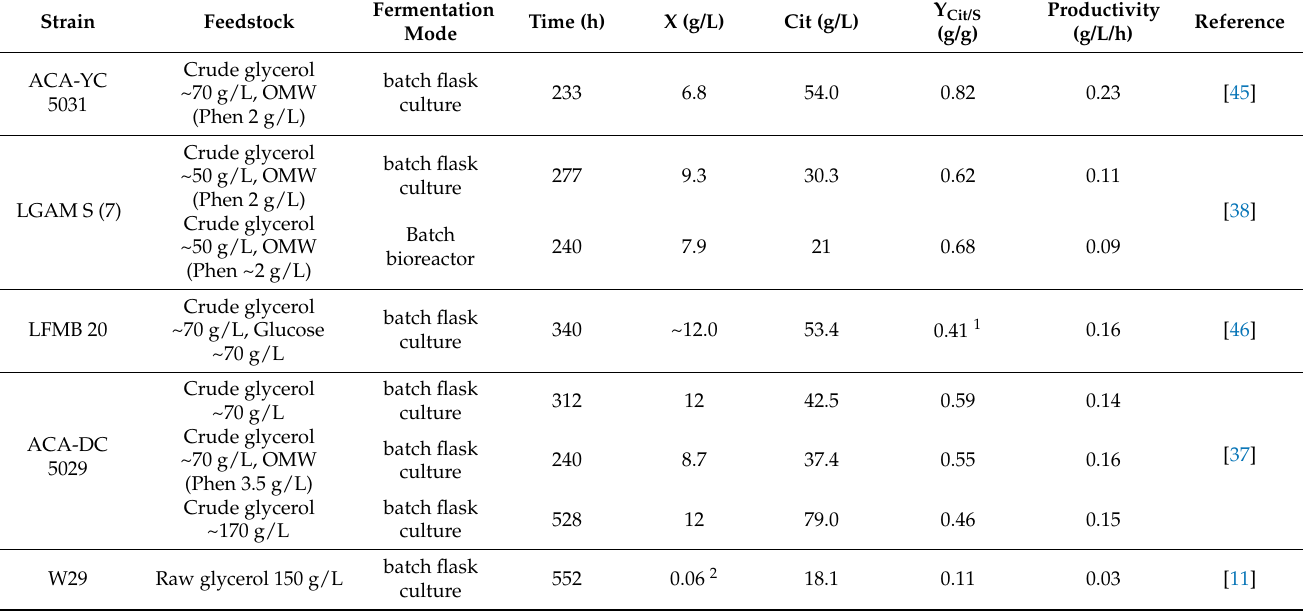
Table 4. Comparative data on citric acid (Cit) production valorizing renewable glycerol when various Y. lipolytica strains were